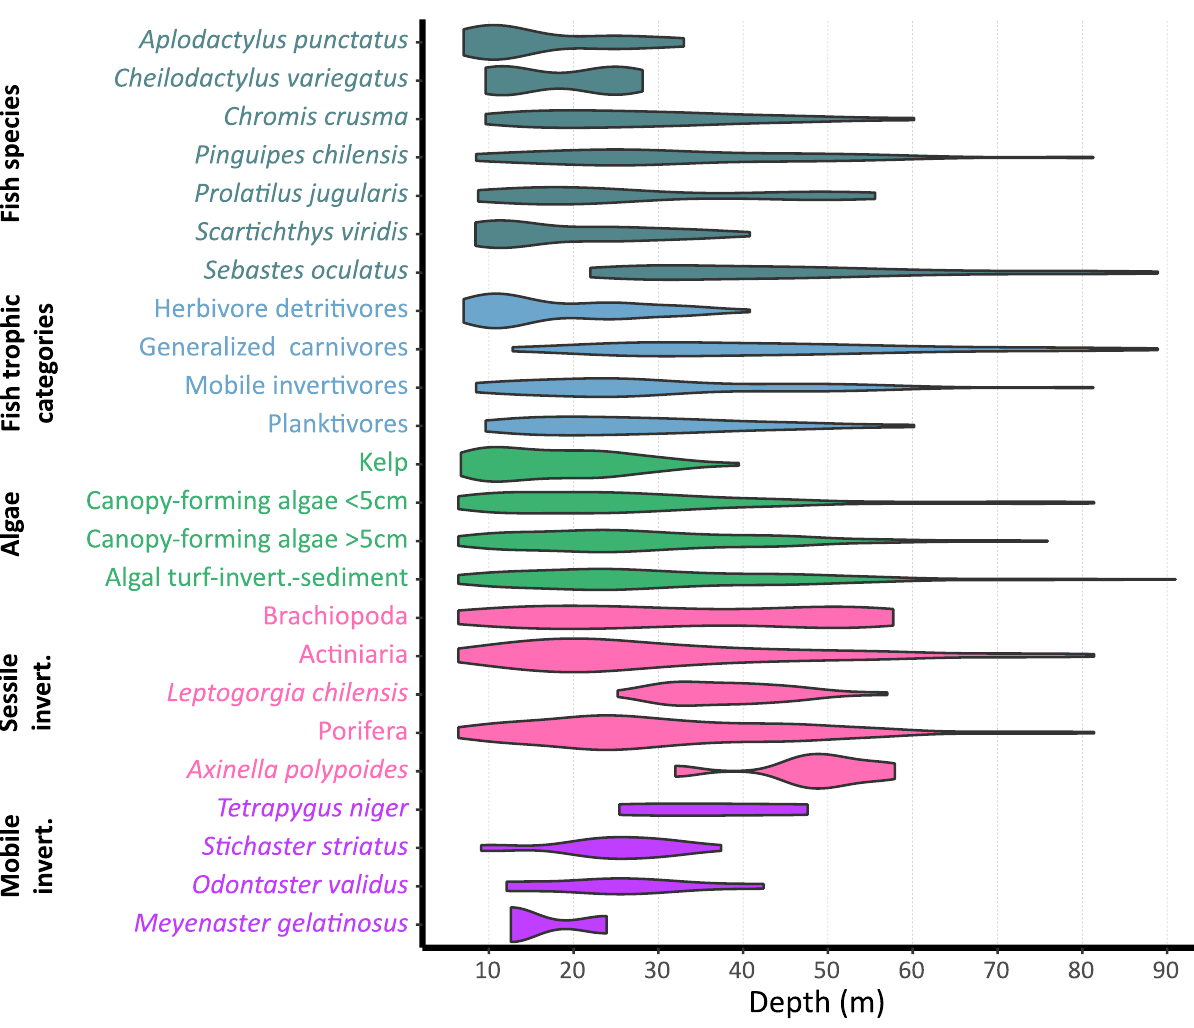
Figure 3. Violin plots showing taxa and fish trophic categories occurrences with depth, based on number of sections where each taxon appeared in the case of fish species and fish trophic categories, and number of 0.25 m 2 quadrats for benthic taxa. Only fish taxa with more than two occurrences on depth sections (N = 120) are individually represented, while all fish taxa were grouped in trophic categories. Invert: